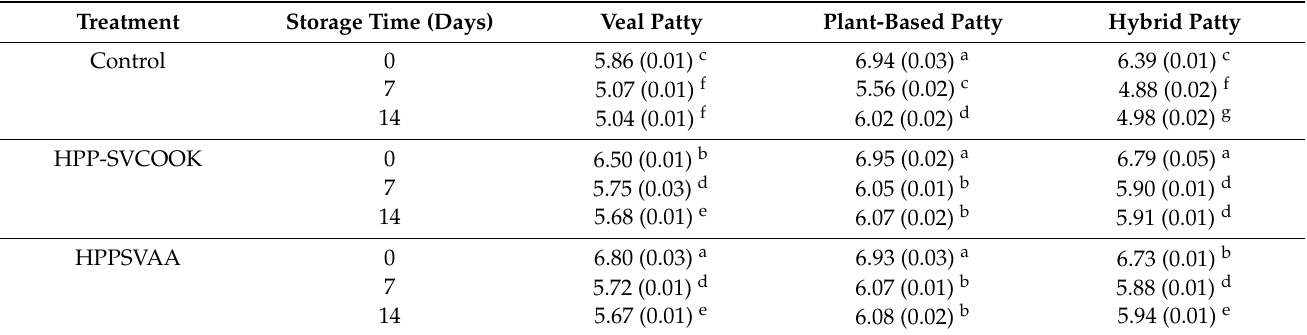
Table 2. Effect of treatments and storage time on the pH (mean value (standard deviation)) of veal, plant-based, and hybrid